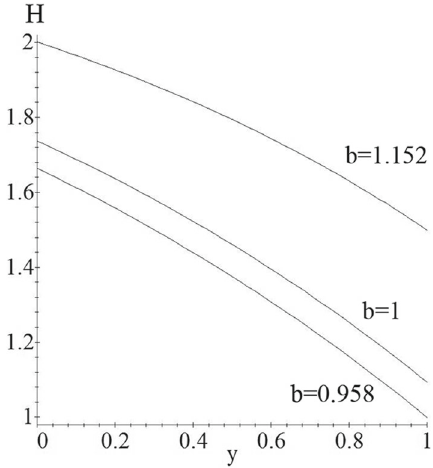
Fig. 2 The decrease of H for the region of Eq.